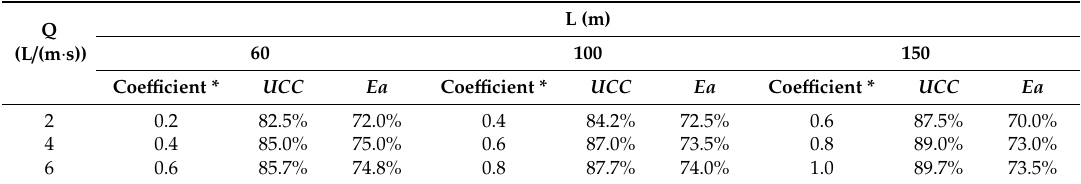
Table 8. The values of non-uniform application coe ffi cient with higher fertilization performance under di ff erent experimental